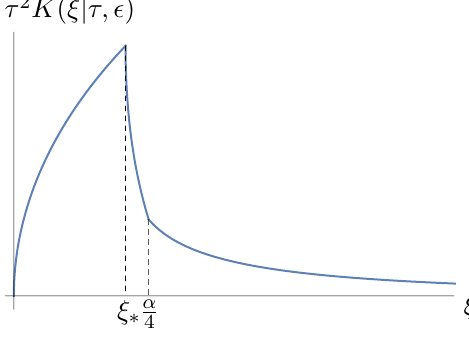
Figure 38. Plot of eq. (C.19) for a choice of α